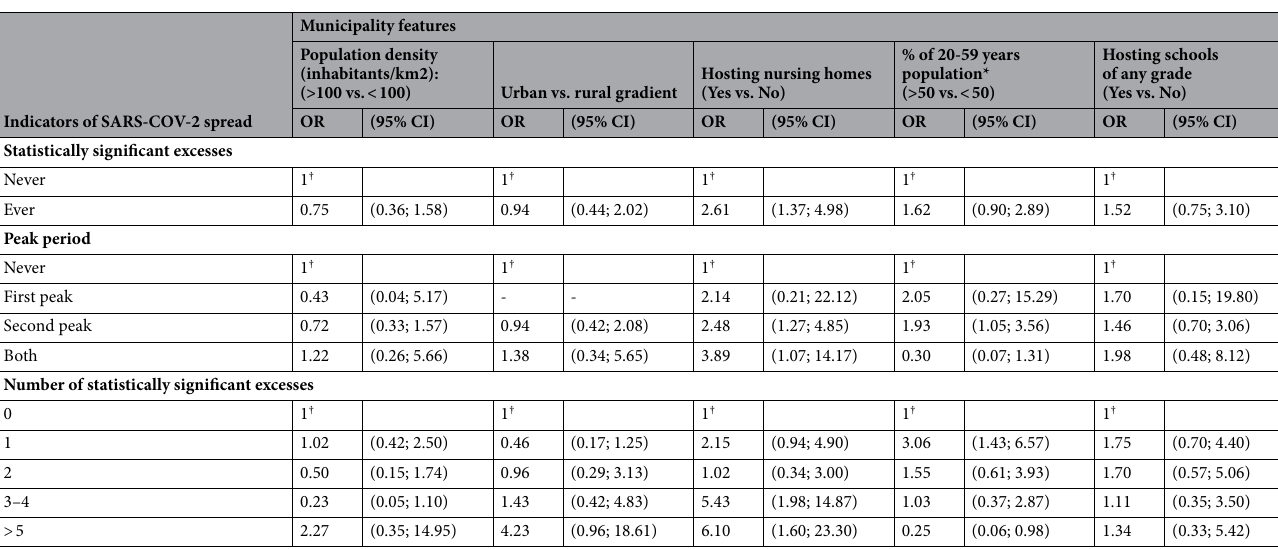
Table 3. Multivariate ‡ odds ratios (OR) of five features of the 215 municipalities of FVG region, and corresponding 95% confidence intervals (CIs), according to three indicators of SARS-COV-2 spread. FVG region, from April 1, 2020 to February 1, 2021. *To total population. † Reference category. ‡ Estimates from logistic regression adjusted mutually for the above features, when